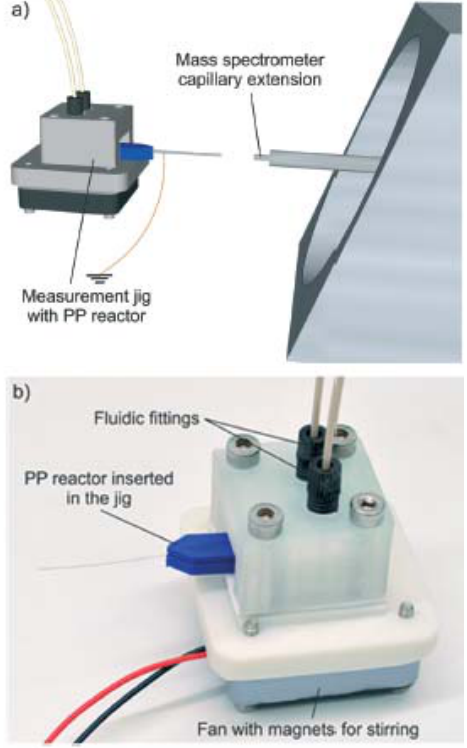
Figure 14. ( a ) Measurement setup; ( b ) Measurement jig with a miniaturized reactor inserted. (Reproduced with permission from [19].)